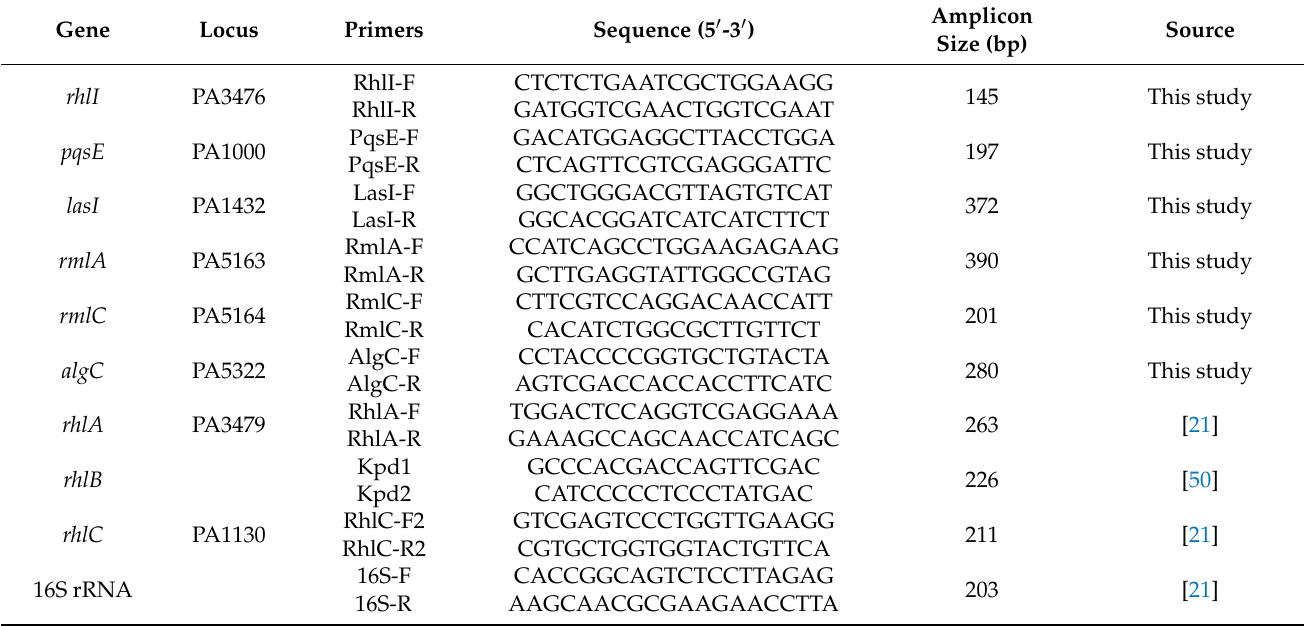
Table 3. Primers used in this